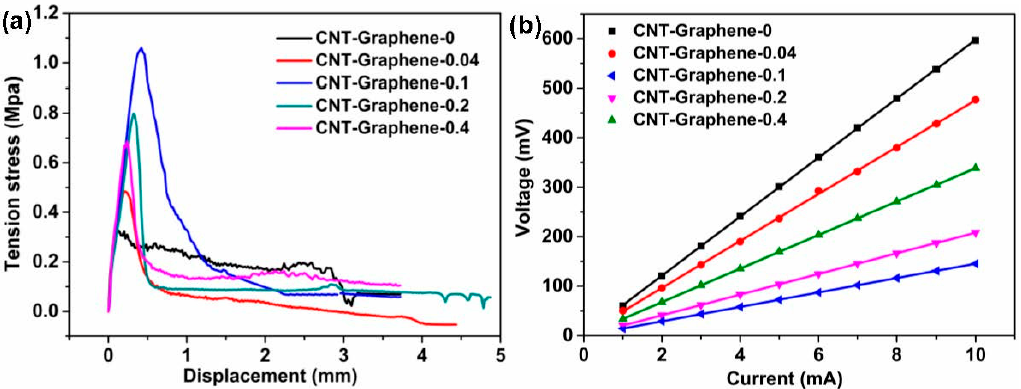
Figure 4. ( a ) Tensile curves and ( b ) surface resistance measurements of the pristine CNT and the CNT-Graphene hybrid electrodes.